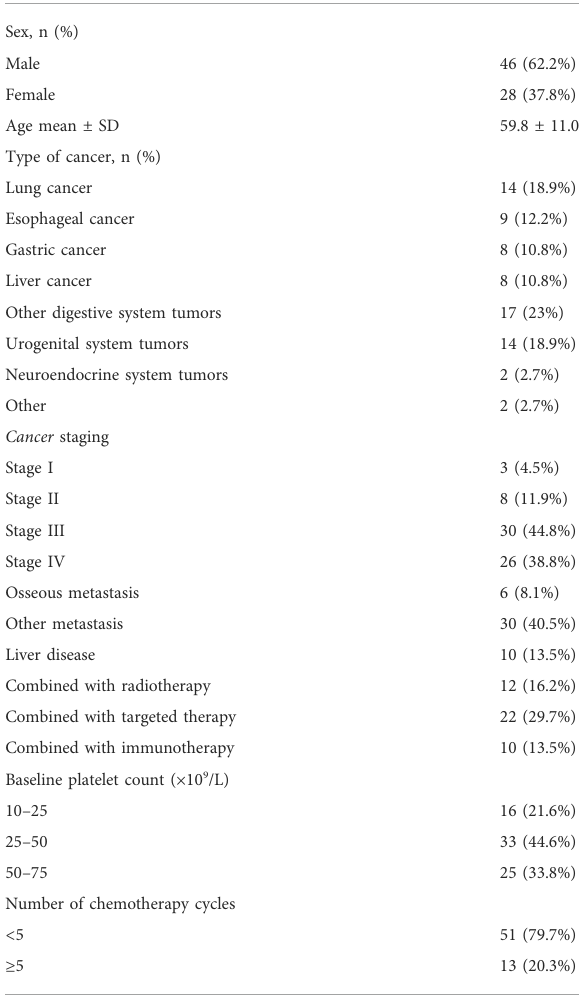
TABLE 1 Baseline characteristics of the